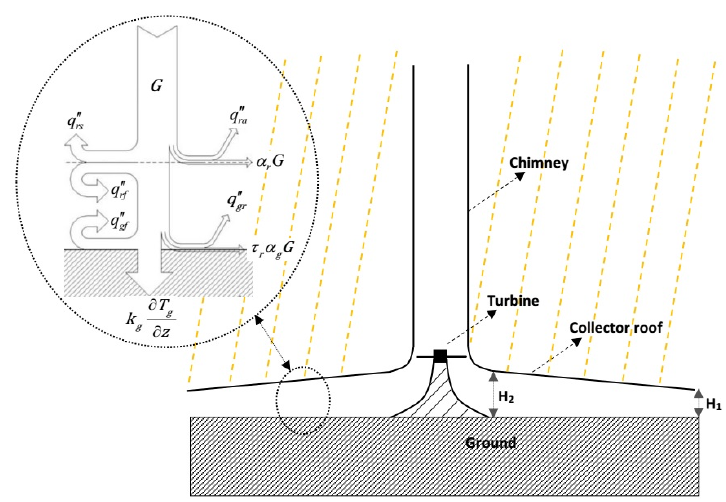
Figure 1. Schematic of an SCPP